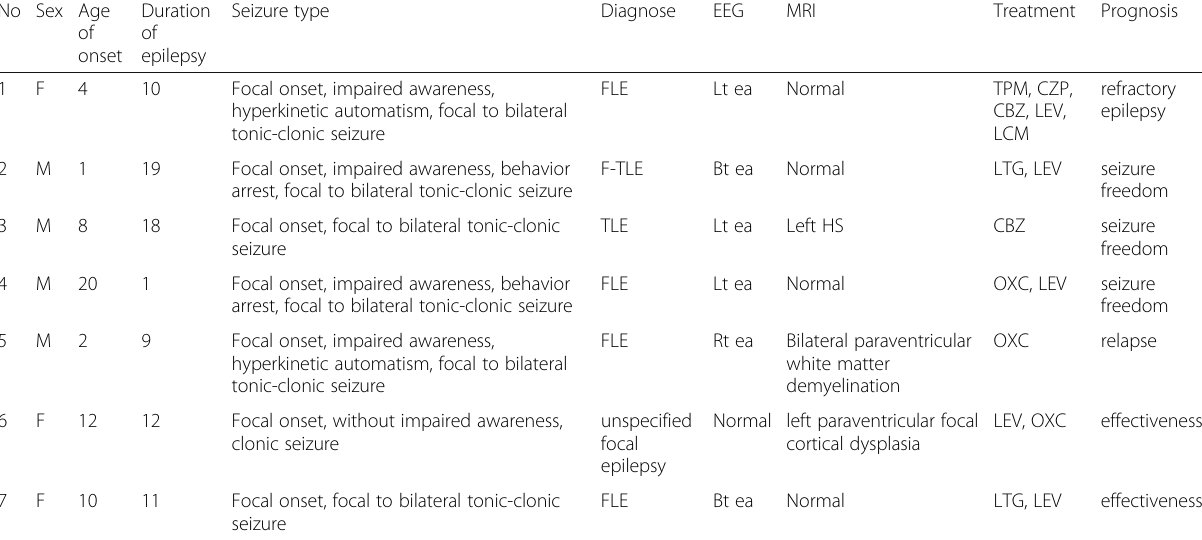
Table 2 Clinical data of the seven patients No Sex Age of